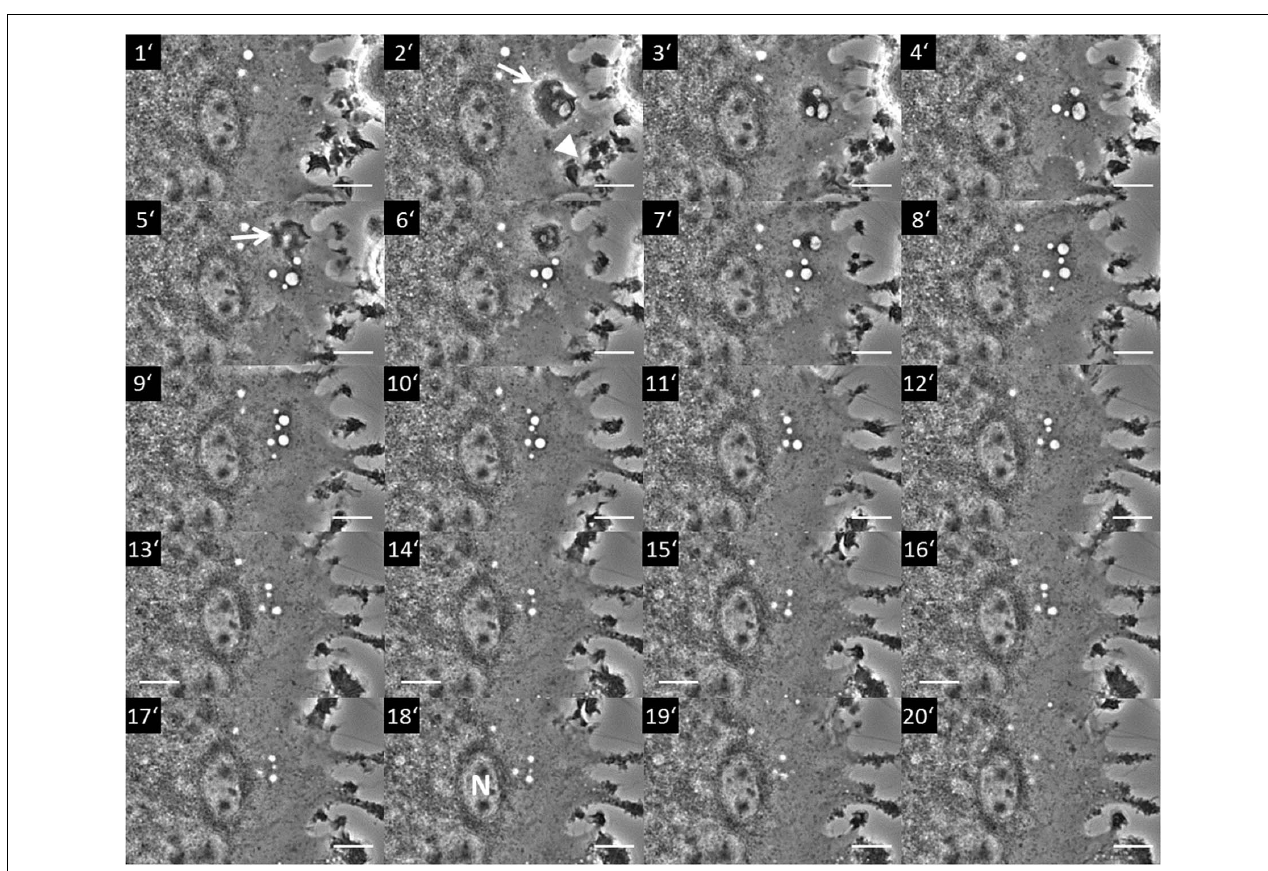
FIGURE 1 | Macropinocytosis occurring in a section of a multinucleated giant cell from a rat non-parenchymal hepatic cell line putatively representing immortalized monocytes (Kupffer cells). The image series shows a section of a giant cell where pinocytosis occurs. The process starts with the formation of a membrane ruffle at minute 2 (2 (cid:48) ; arrow) from which an array of vesicles (pinosomes) originates (3 (cid:48) –4 (cid:48) ). Further ruffling can be seen at the cell periphery (2 (cid:48) ; arrowhead). A second ruffle is forming at minute 5 (5 (cid:48) ; arrow) from which additional pinosomes derive (5 (cid:48) –7 (cid:48) ). The whole pinosome array subsequently moves toward the center area of the giant cell (8 (cid:48) –18 (cid:48) ) locating to the vicinity of a nucleus (N in 18 (cid:48) ). Terminally, the vesicles start to disappear in the perinuclear (pericentral) cytosol (20 (cid:48) ). Scale bar = 10 µ m. The whole live cell imaging sequence can be seen in Supplementary Video 1 .